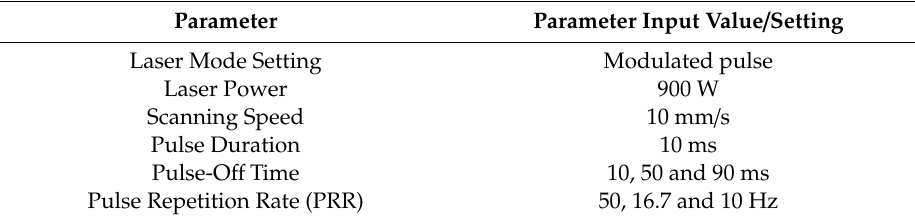
Figure 6. Energy delivery pattern: ( a ) continuous wave; ( b ) modulated pulse wave. Table 4. Parameters for laser drilling with pulse mode operation.